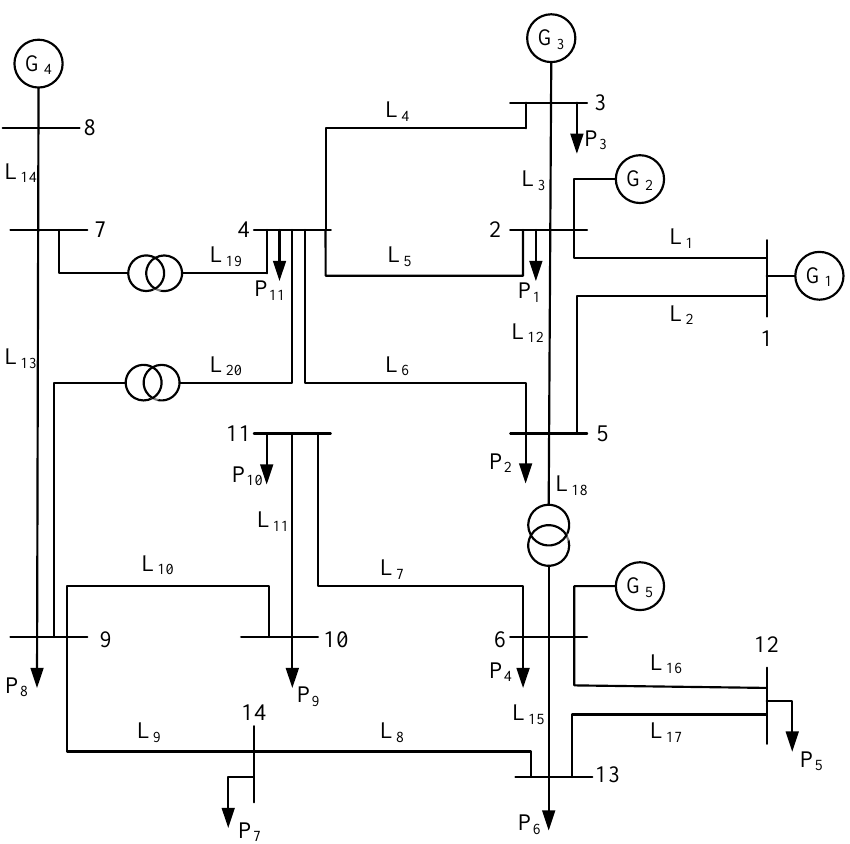
Figure 6. The structure of 14-bus system.